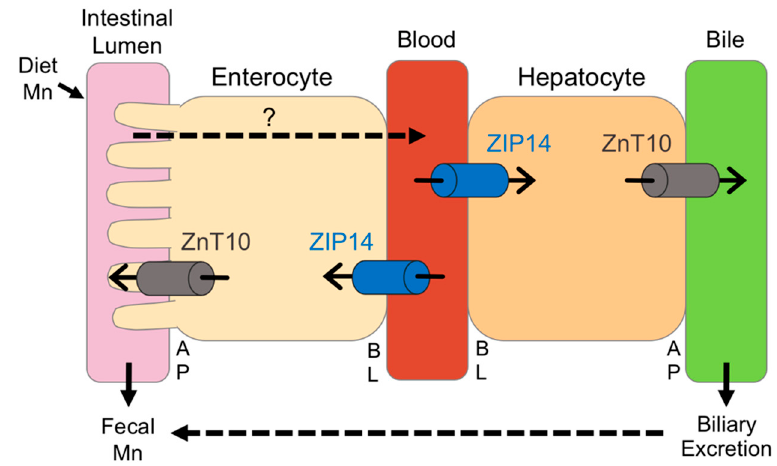
Figure 8. Proposed model for the regulation of ZIP14 and ZnT10 under high-Mn conditions. The transporters required for dietary Mn absorption across the apical (AP) and basolateral (BL) membranes of enterocytes are not fully established. In the intestine, ZIP14 transports blood Mn into the enterocyte, while ZnT10 secretes Mn from the enterocyte into the intestinal lumen, both limiting absorption. In the liver, ZIP14 takes up Mn from the blood into the hepatocyte, while ZnT10 secretes Mn into the bile. In male mice, when dietary intake of Mn is high, intestinal ZIP14 and ZnT10 are upregulated to reduce absorption, and hepatic ZIP14 and ZnT10 are upregulated to increase biliary excretion. In female mice, however, only hepatic ZIP14 is significantly upregulated during high dietary Mn conditions.